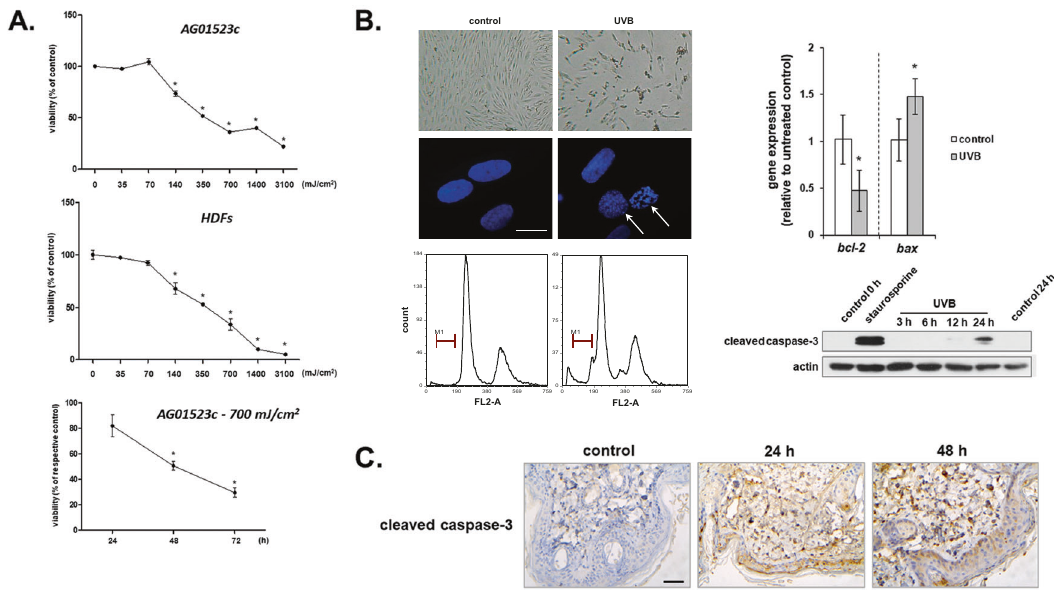
Fig. 1 Exposure of human skin fi broblasts to UVB radiation leads them to a programmed cell death in vitro and in vivo. A AG01523c and primary human dermal fi broblasts from an adult donor (HDFs) were irradiated under a UVB lamp for durations corresponding to irradiation doses ranging from 35 to 3100 mJ/cm 2 . After incubation at 37 o C for 72 h, cells were detached by trypsinization and red-colored metabollicaly active cells after staining with Neutral Red were measured using a haemocytometer. In addition, AG01523c fi broblasts were irradiated with a UVB dose of 700 mJ/cm 2 before staining with Neutral Red and cell counting 24, 48, and 72 h post-irradiation. Untreated cells served as the reference sample for the estimation of cell viability. Representative graphs out of at least three similar ones from independent experiments are shown here. Asterisks denote statistically signi fi cant differences compared to the untreated control at the respective time-point ( p < 0.05, Student ’ s t test). B Cells exposed to a 700 mJ/cm 2 UVB irradiation dose were observed under a light or fl uorescence [after staining with 2 μ g/ mL 4 ́ ,6-diamidino-2-phenylindole (DAPI)] optical microscope for the presence of typical apoptotic features; fi xed with 50% (v/v) ice-cold ethanol and stained with PI before cell cycle analysis to reveal the incidence of characteristic sub-G1 peaks; subjected to RNA and protein extraction to assess bcl-2 and bax mRNA levels by RT-qPCR and caspase-3 activation by western blot analysis, respectively. Representative microscopic images, histogram plots, relative gene expression graphs, and western blots of three independent experiments are shown. Arrows in the fl uorescence microscopic pictures depict regions of condensed/fragmented chromatin in the DAPI stained nuclei (scale bar = 20 μ m). M1 marker designates the sub-G1 peak corresponding to apoptotic cells with fragmented DNA preceding the characteristic G1 and G2/M peaks in the histogram plots of PI-stained cells. Asterisks denote statistically signi fi cant differences in the gene expression of UVB- exposed fi broblasts in comparison to the untreated control ( p < 0.05, Student ’ s t test). Staurosporine was used as a known apoptosis inducer leading to caspase-3 cleavage, while western blot analysis against actin served as the loading control. C SKH-1 hairless mice were exposed to 350 mJ/cm 2 of UVB radiation and the dorsal skin was surgically removed 24 and 48 h post-irradiation for the assessment of cleaved caspase-3 in situ expression in the skin sections after immunohistochemical staining. Pictures shown here are representative of three independent experiments. Scale bar = 50 μ